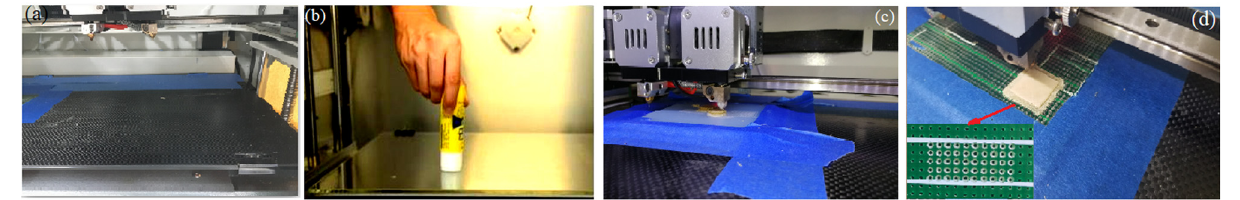
Figure 2: The modification of FDM platform: ( a ) a platform proved by manufacturer, ( b ) spreading a glue evenly on the platform, ( c ) pasting a polycarbonate ( PC ) plate on the platform, and ( d ) pasting a PCB plate on the platform.